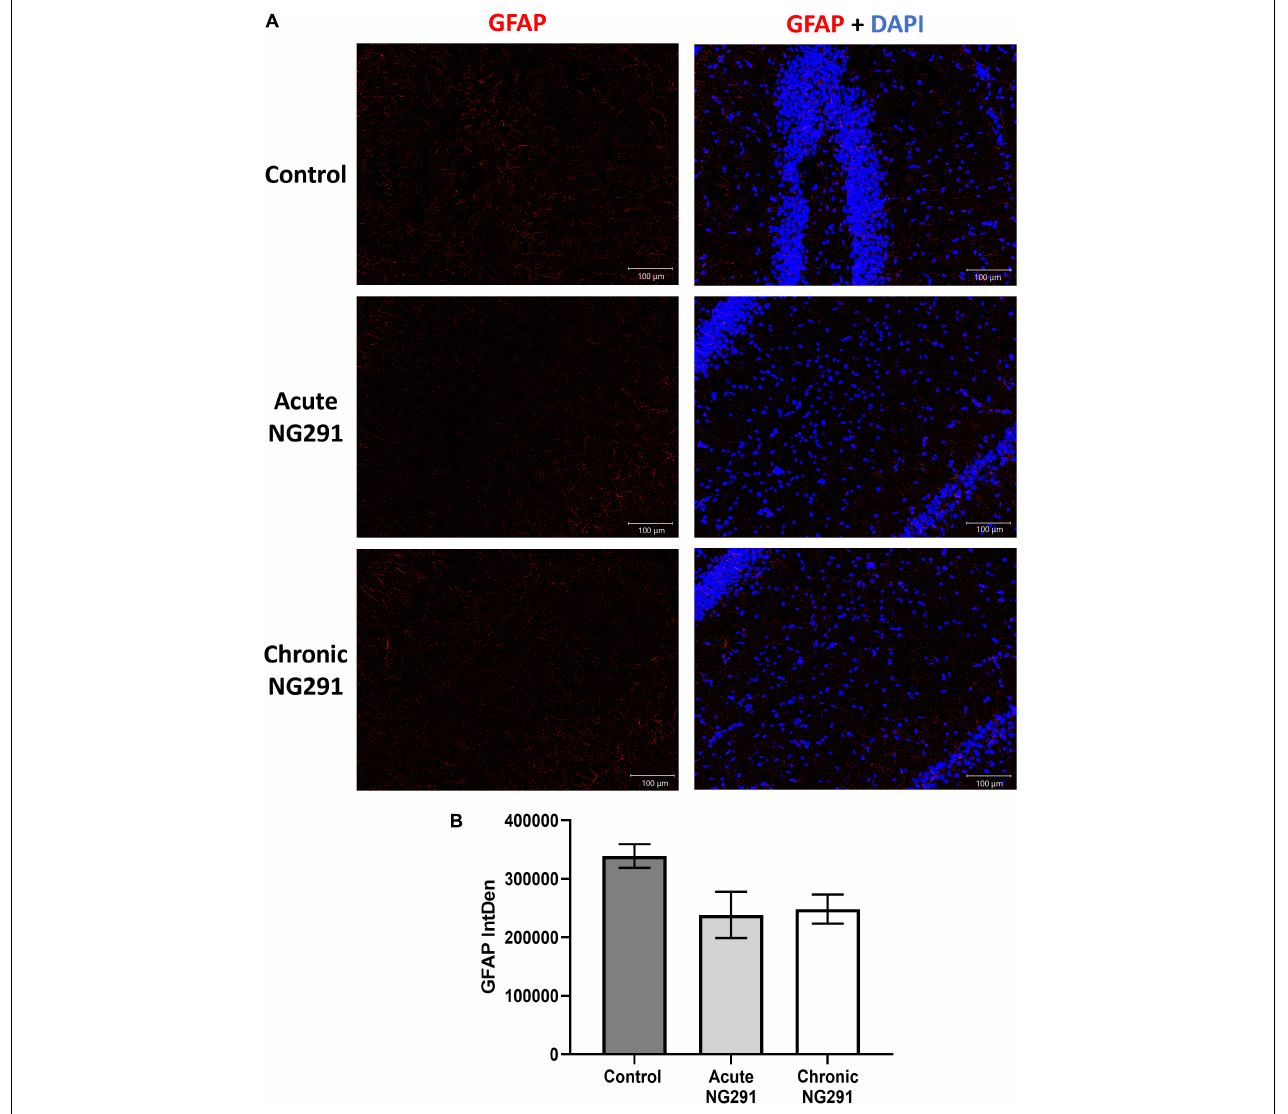
FIGURE 7 | Astrocyte activation: analysis via GFAP detection. Sprague Dawley rats were treated with: saline, acute (100 µ g/kg) NG291, or chronic NG291 (100 µ g/kg every 24 h for 3 days, total three doses). Harvested brains were sectioned coronally 20 µ m thick. Keyence BZ-X800 fluorescence microscope was used to detect positive GFAP cell staining. Brain sections (interaural 5.20 mm, Bregma –3.80 mm) were imaged at 10 × under the same conditions. Panel (A) displays GFAP expression at the CA1 hippocampus in different experimental conditions. The scale bar: 100 µ m in length. Panel (B) shows GFAP quantification across the entire cross-section by stitching 10 × images together (200–210 images) using the software supplied by the Keyence BZ-X800 fluorescence microscope. Data are expressed in terms of mean ± SEM. Ordinary one-way ANOVA was conducted, revealing p -values above 0.05 when comparing GFAP expression in control conditions vs. acute or chronic 100 µ g/kg of NG291 treated rats. Post hoc power analysis was calculated with an alpha of 0.05 at 80.6%. n = 5 in all